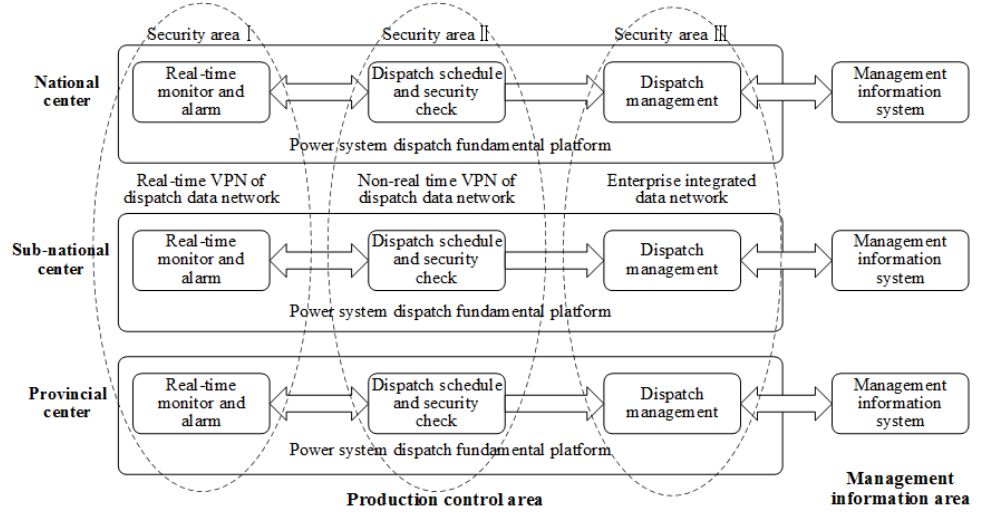
Figure 2. Schematic diagram of vertical connection of the dispatch system in China.